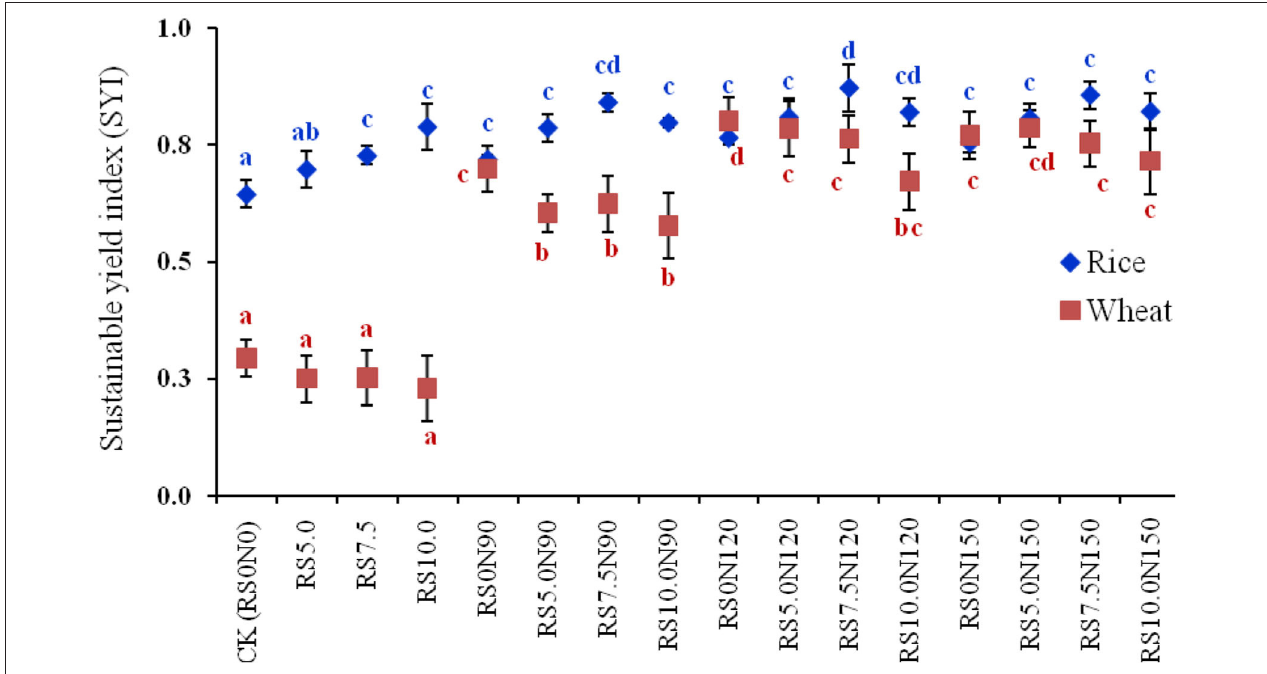
FIGURE 1 | Sustainable yield index (SYI) of rice and wheat grown under rice-wheat cropping system in north-western India. Line bars indicate standard error from mean . Values for a crop followed by different letters are significantly different at p < 0.05 by Duncan’s multiple range test (DMRT).